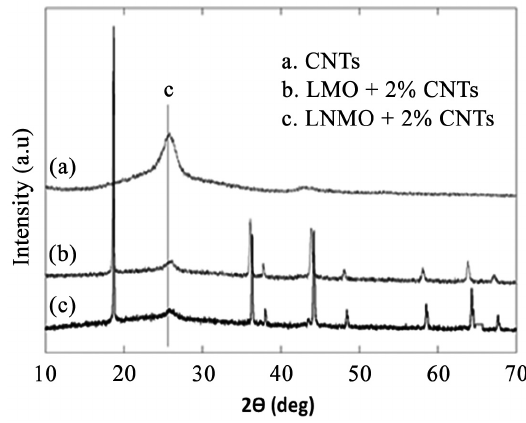
Figure 6. XRD of LMO (LNMO)/CNTs